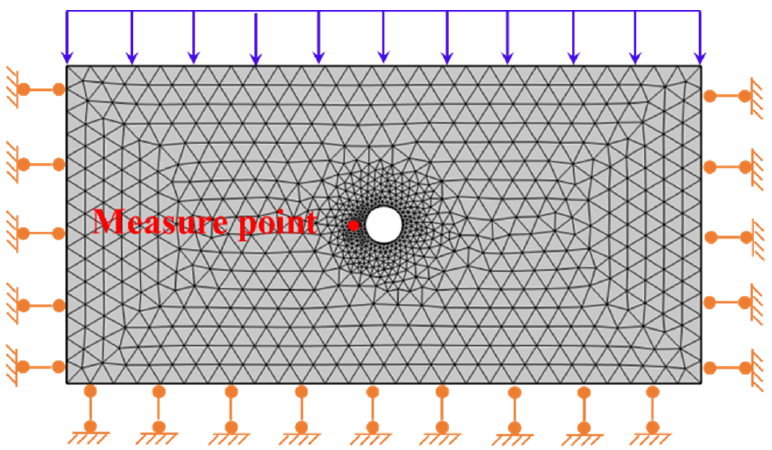
Figure 4. Numerical model.